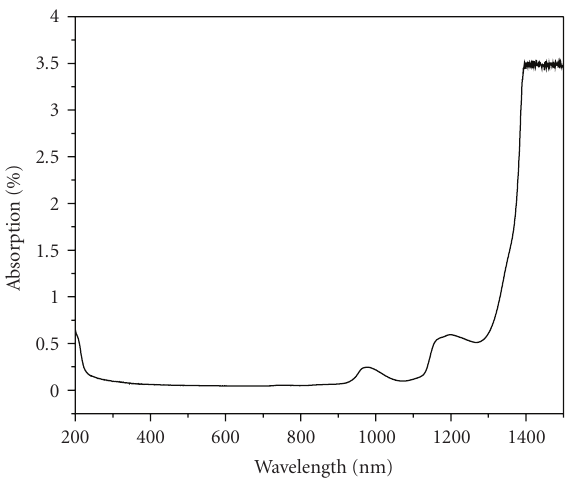
Figure 16: UV-Vis-NIR spectrum of